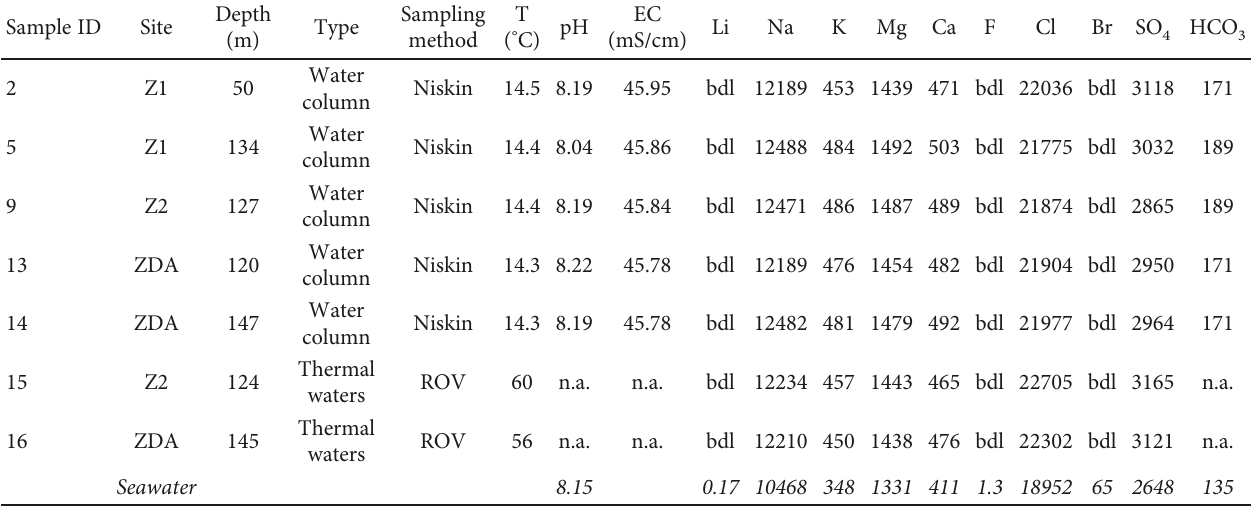
Table 2: Chemical analyses of the water samples. Concentrations in mg/l. Local seawater composition is reported for comparison. Sample ID